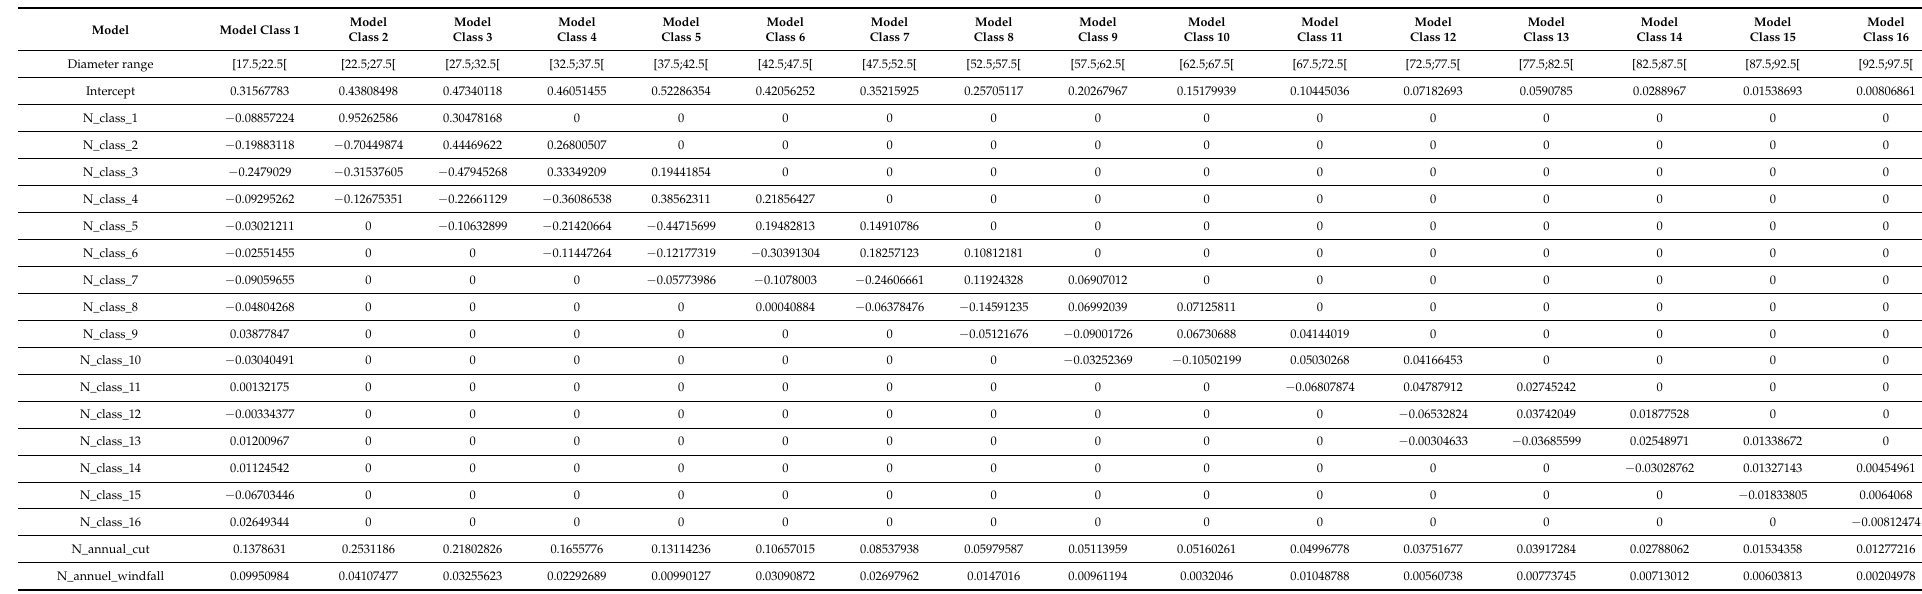
Table A3. Regression coefficients for linear models trained on the whole data set (class center in cm = (#class − 1) × 5 +